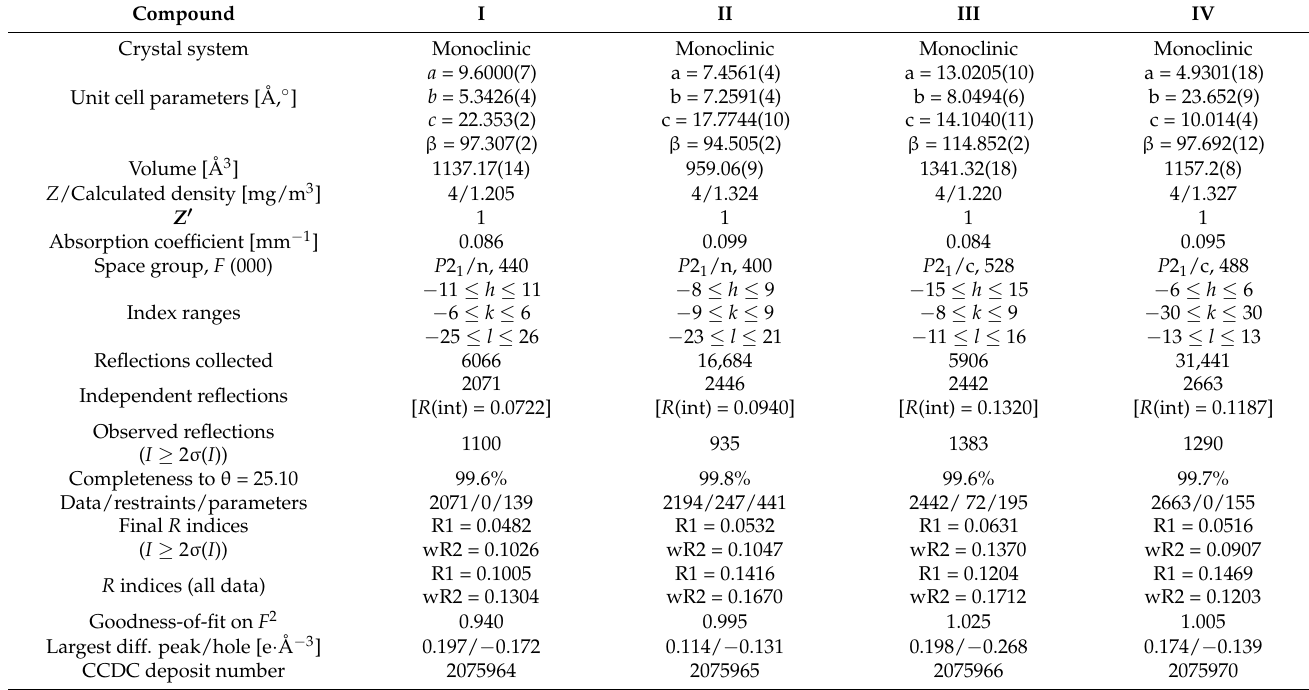
Table 1. Experimental